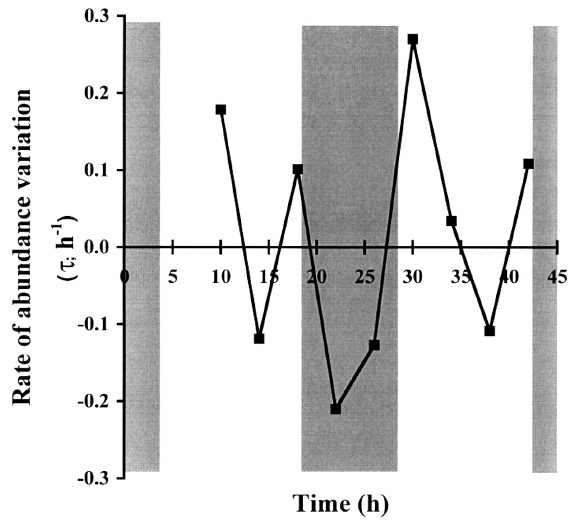
F IG . 6. – Rate of variation ( τ , h -1 ) of the cyanobacteria abundance integrated over the 0-90 m upper layer during the 36 h cycle. Neg- ative values mean that predation overruled cell division during the referred interval. The abscisses of data points correspond to the midpoints of the time intervals for which τ is